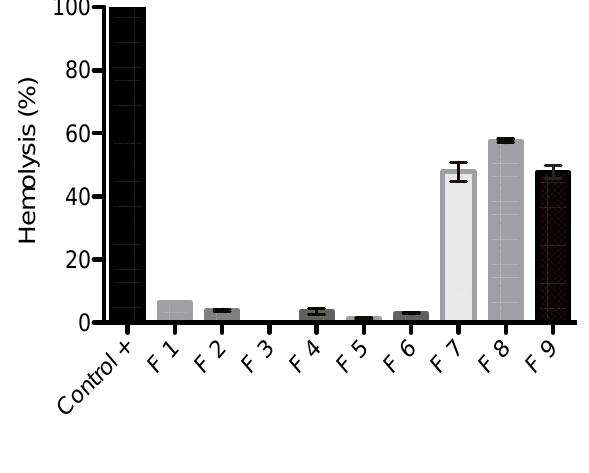
Figure 6. Hemolytic activity of SLNs F1–F9 against human erythrocytes. Blood cells were exposed to SLNs for one